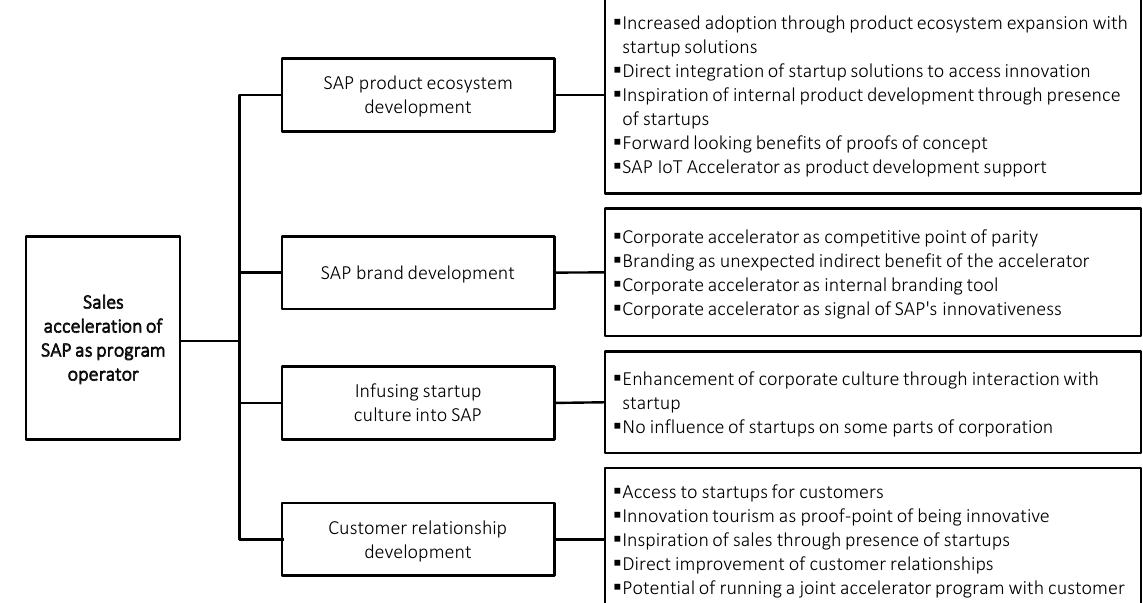
Figure 5. Sales acceleration of SAP as program